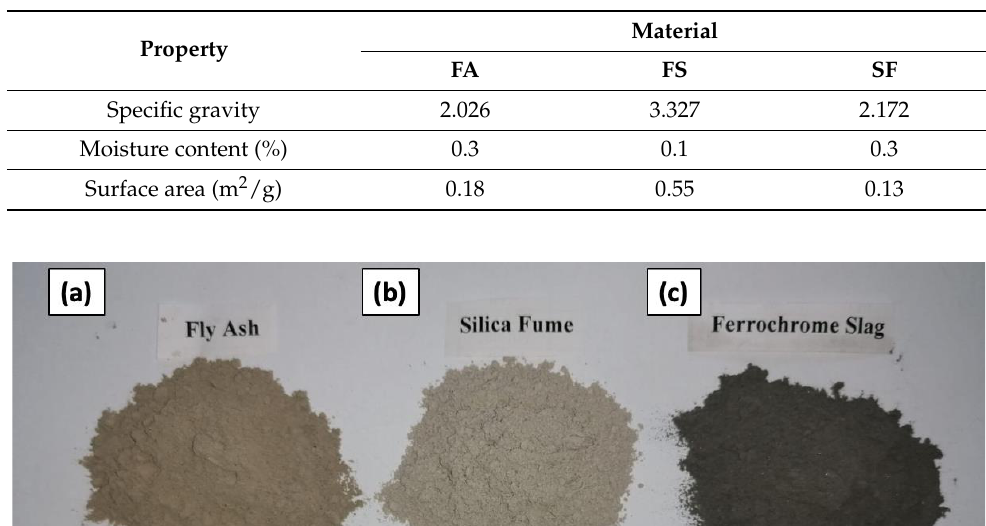
Table 2. Physical properties of FA, FS, and SF.